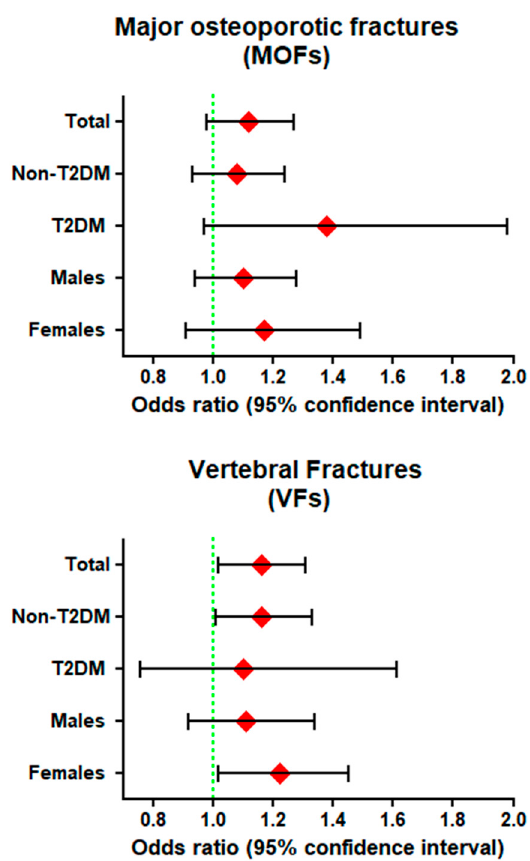
Figure 2. Odds ratio (ORs) of energy-adjusted CML for MOF and VFs in non-type 2 diabetics (non-